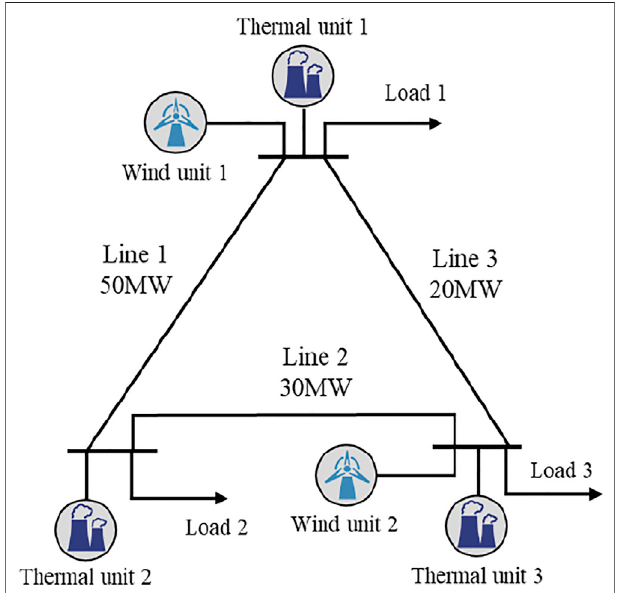
FIGURE 4 | Structure diagram of the 3-bus power system under